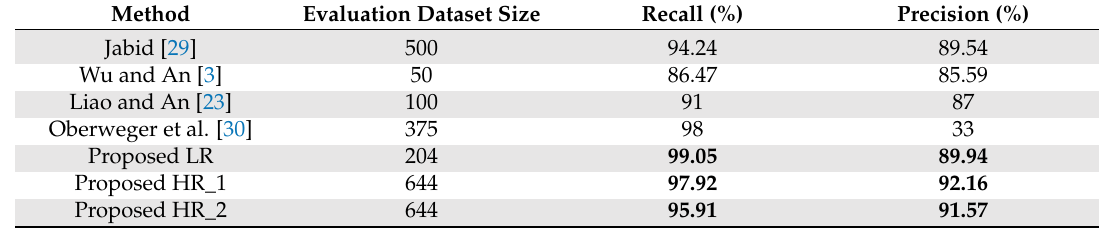
Table 3. Summary of performance comparison (Polymer Insulator Only).